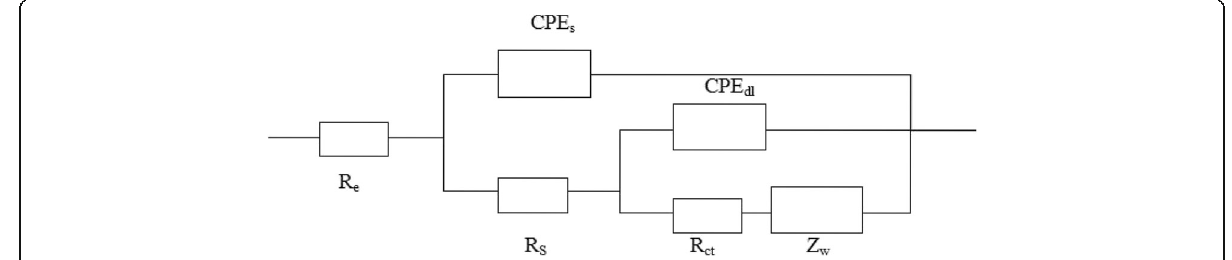
Fig. 10 The equivalent circuit for the Nyquist plots